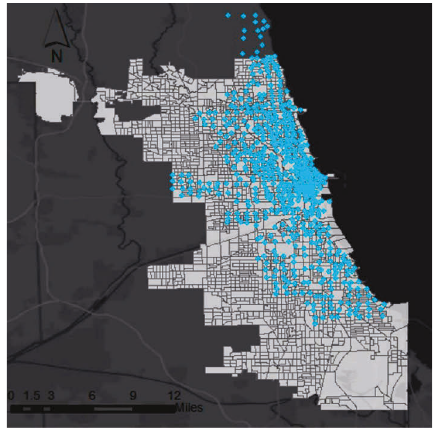
Figure 1: Divvy bicycle stations in the city of Chicago.